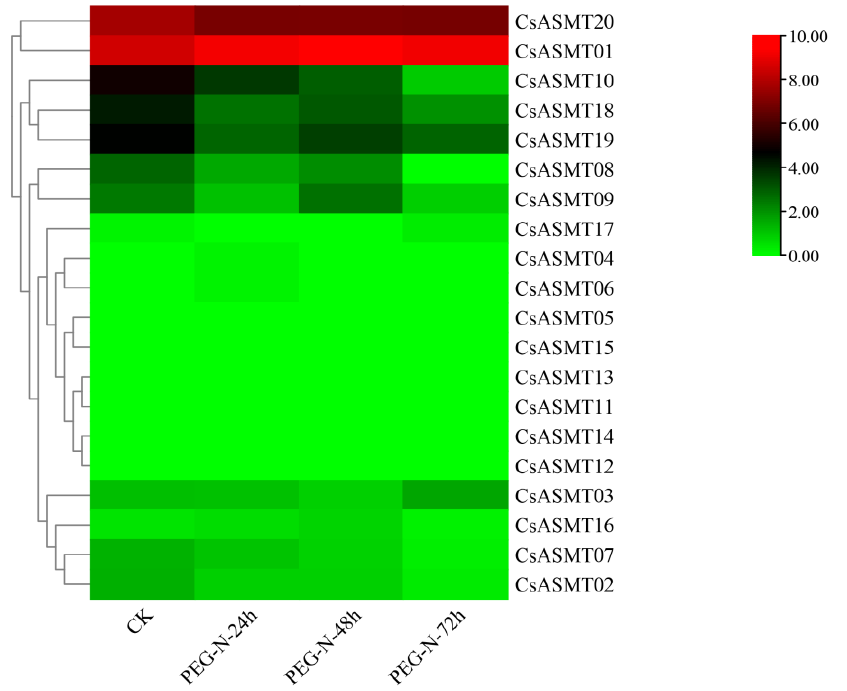
Figure 8. Heat map of FPKM expressions of C. sinensis ASMT genes under drought stress based on RNA-Seq data. FPKM values were all log2-processed, and heat map clusters were constructed. The color scale representing relative expression values is shown on the left.